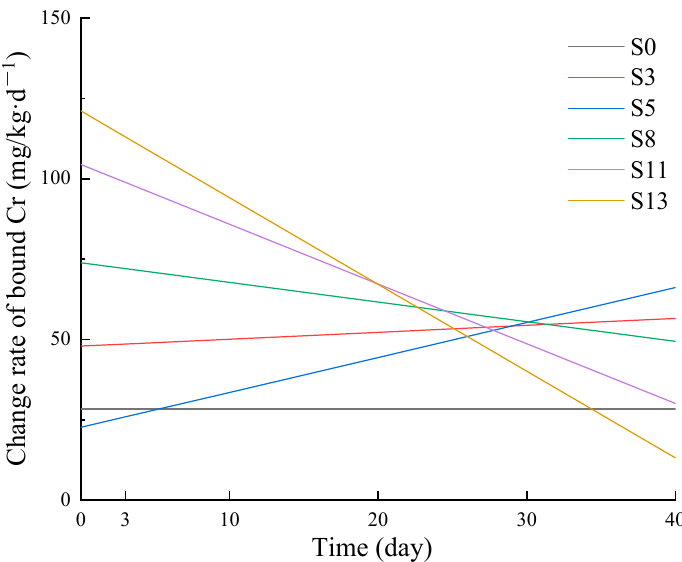
Figure 4. Change rate of bound fraction during remediation.